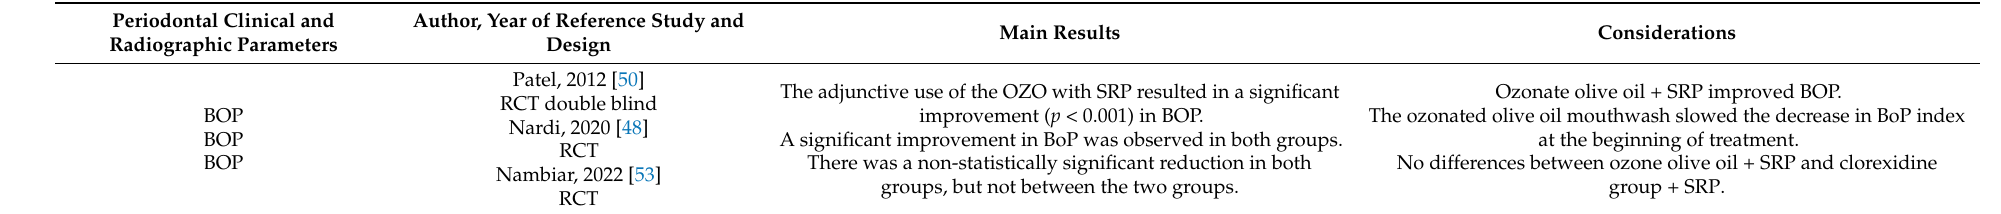
Table 5. Characteristics of periodontal clinical, radiographic parameters and inflammatory parameters for ozonate oil, including clinical attachment loss (CAL), probing depth (PPD), bleeding on probing (BoP), plaque index (PI), gingival index (GI), marginal bone levels (MBL), matrix metalloproteinase (MMP-8) and periodontal treatment with Scaling and Root Planing